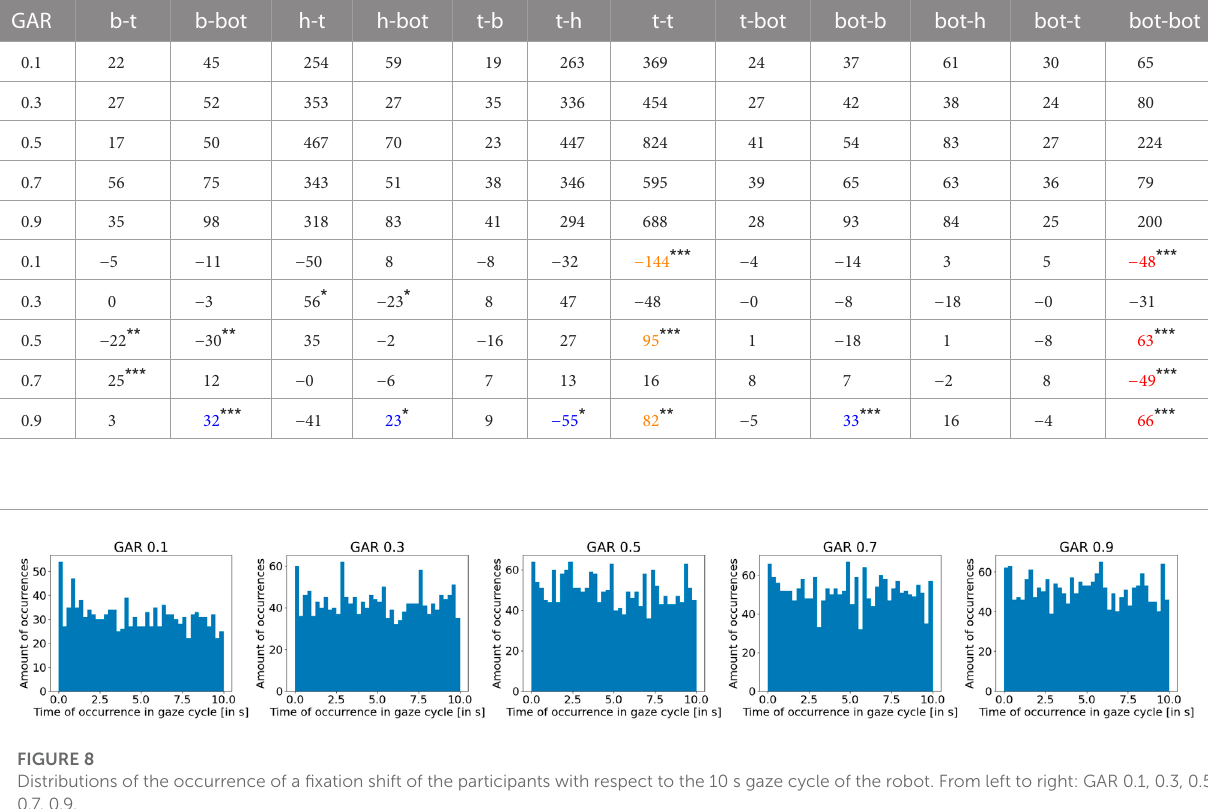
TABLE4 Top:observedtransitioncountsbetweentheROIsbody(b),head(h),top(t),andbottom(bot).Bottom:differencesintransitioncount (observed−expected)forthetransitionsbetweentheROIsbody(b),head(h),top(t),andbottom(bot).Theadjusted α levelis 0 . 00083 (*),0.00017(**),and